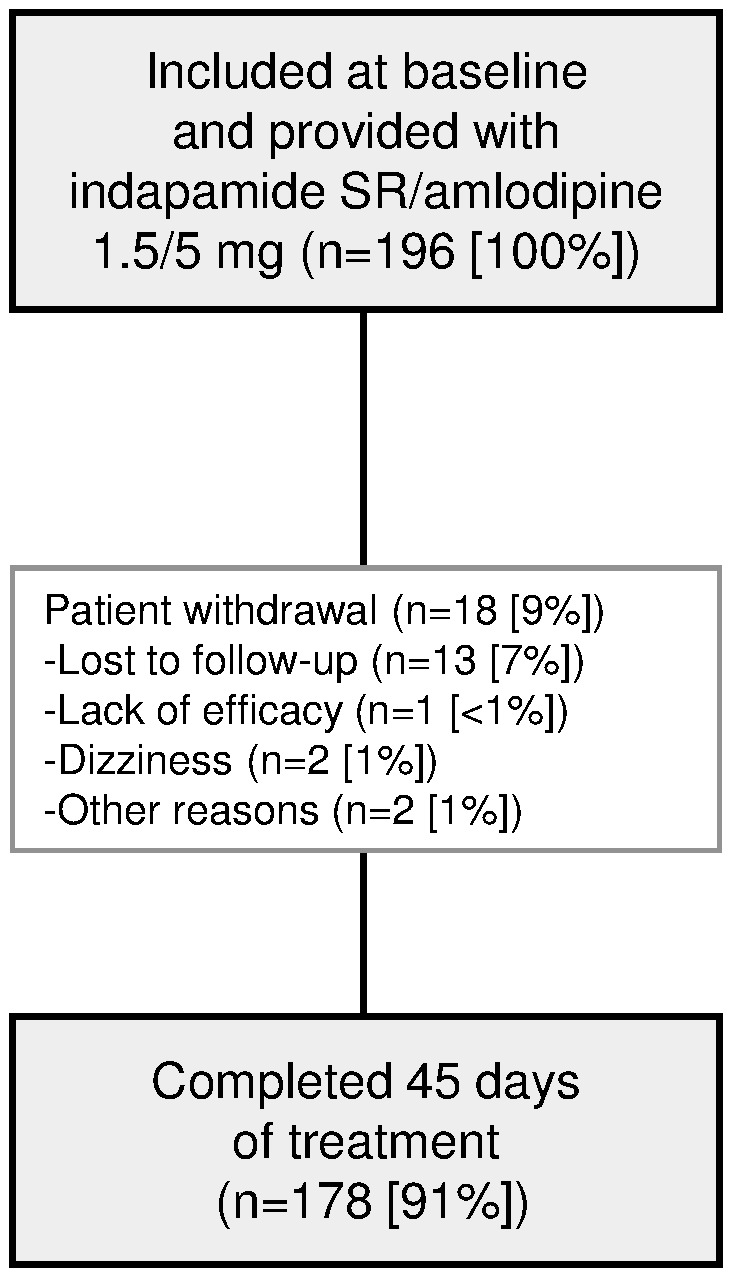
Study flowchart.